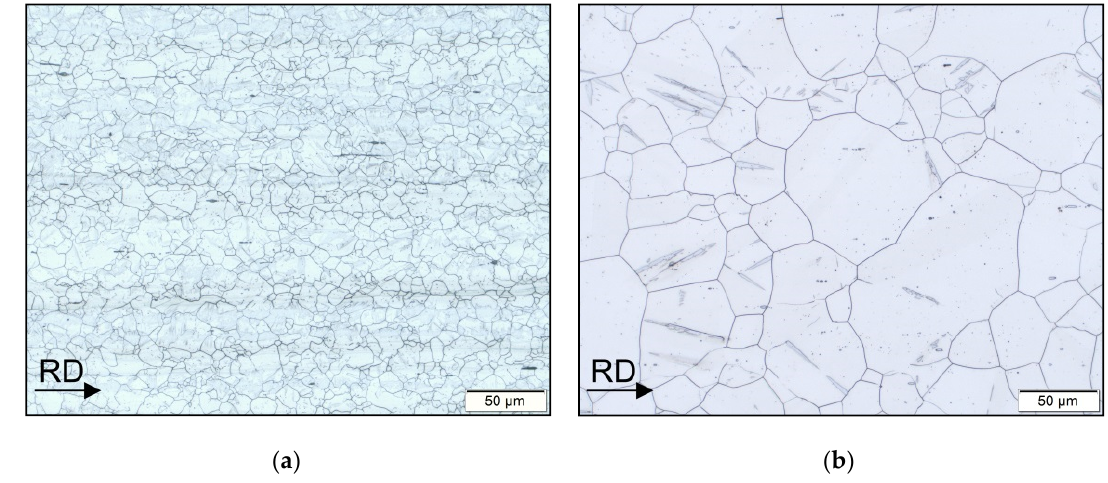
Figure 1. Microstructures of ( a ) the 3.5-mm hot-rolled strip and ( b ) the solution-annealed-1.8 mm cold-rolled strip. The arrows indicate the rolling direction (RD).